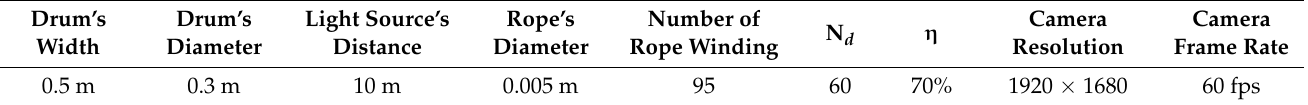
Figure 17. Hardware setting diagram of the laboratory reel rope guiding detection. Table 4. The specific parameters of experiments in the